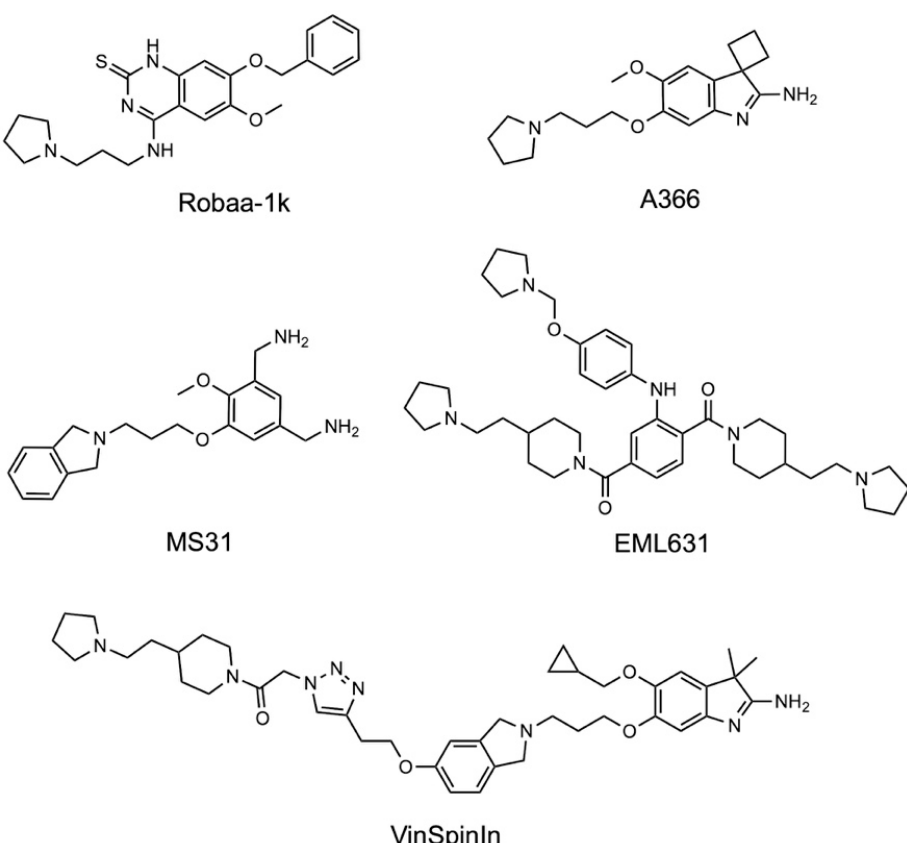
Figure 1. Structures of reported Spindlin1 inhibitors.